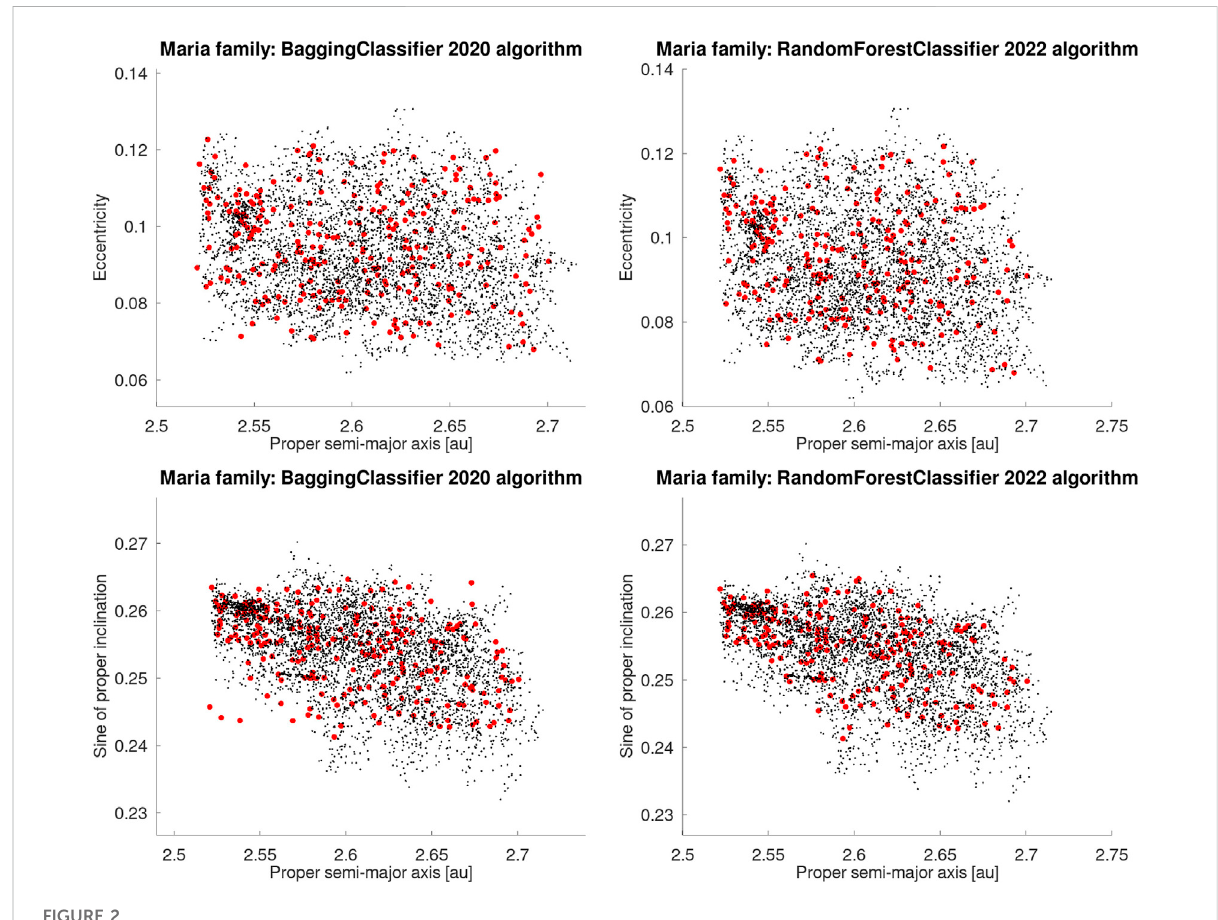
FIGURE 2 Same as in Figure 1 but for the 170 Maria family.